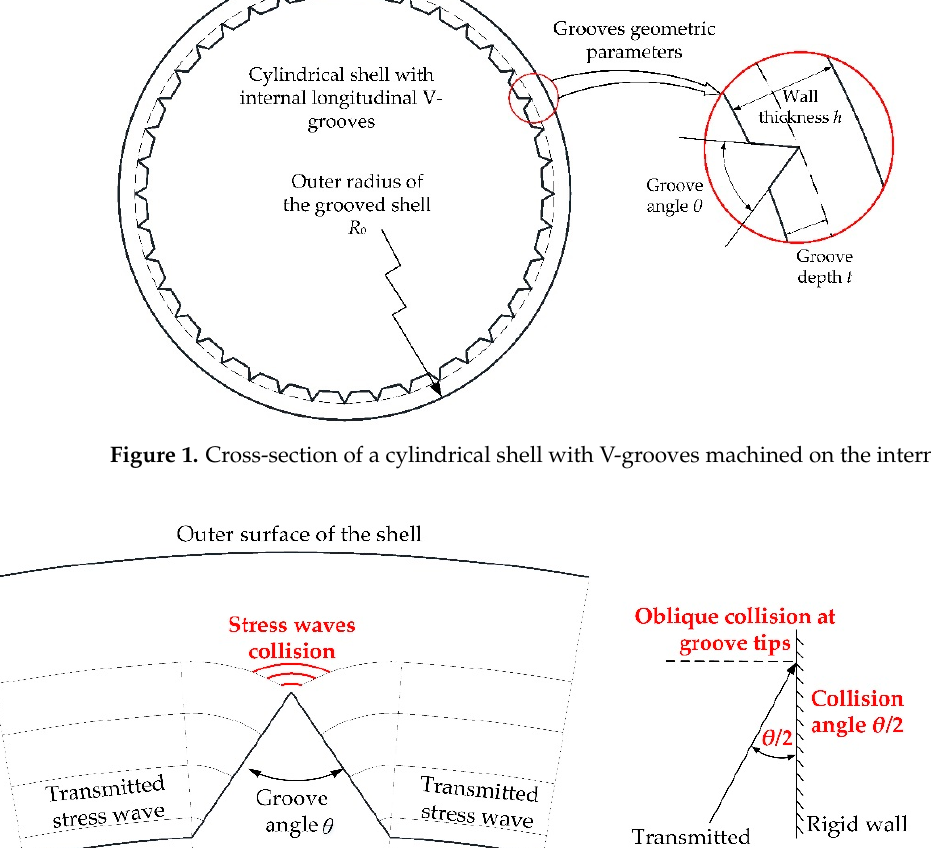
Figure 1. Cross-section of a cylindrical shell with V-grooves machined on the internal surface.